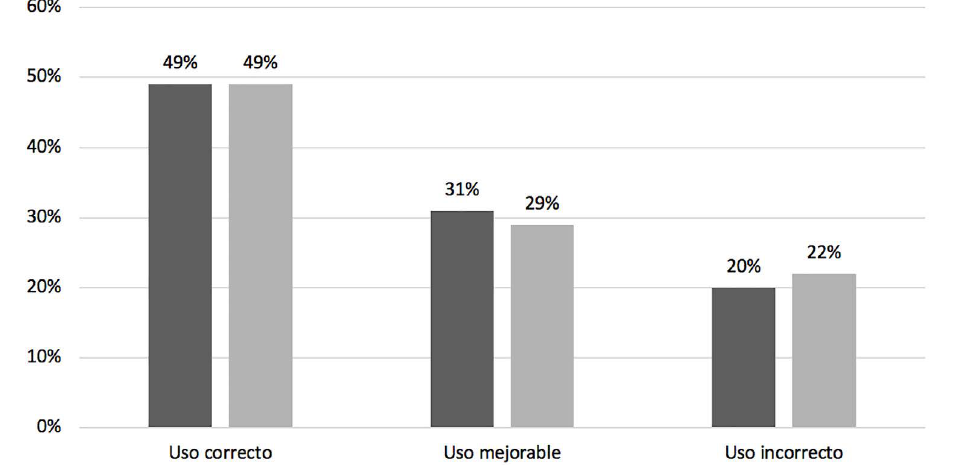
Figure 4. Adequacy of the composition to the theme in original photographs taken by future teachers. Source: